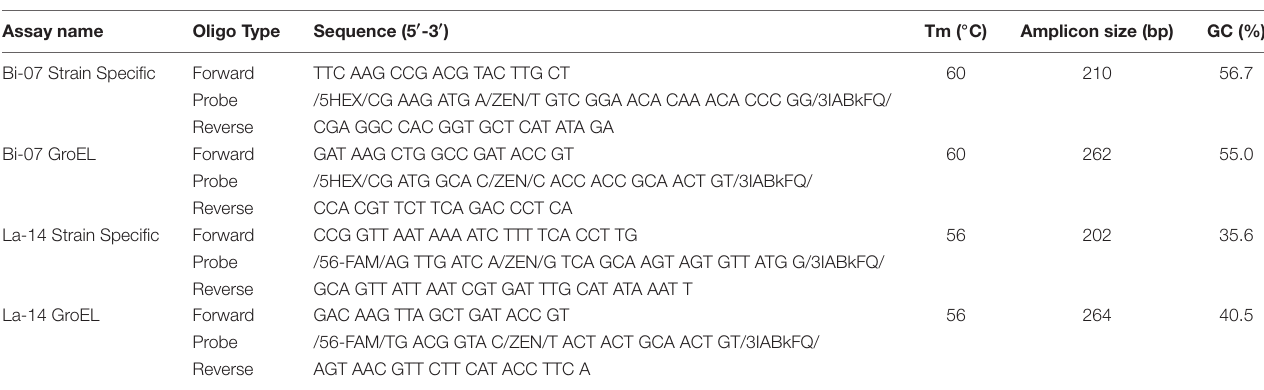
FIGURE 1 | T-Coffee alignment of the first 450 bp of the GroEL gene for La-14 and Bi-07 (Notredame et al., 2000). Overlaid on the alignment are the locations of the primers and probes designed for this target. * For melting temperature purposes, the first two base pairs on the 5 (cid:48) end of Reverse Primer were only utilized in La-14 GroEL assay. TABLE 1 | Strain specific and GroEL assays for La-14 and